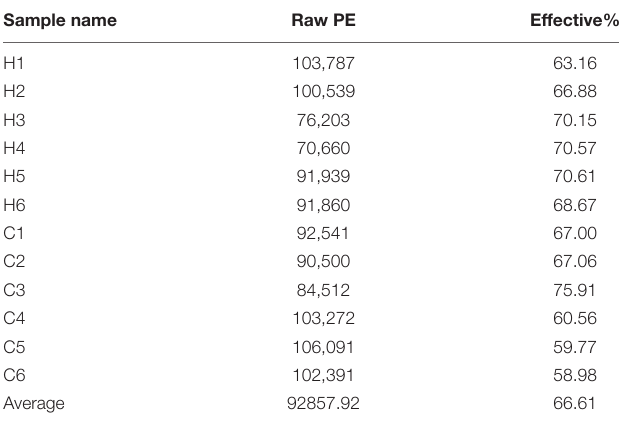
TABLE 3 | Data preprocessing, statistics, and quality control.